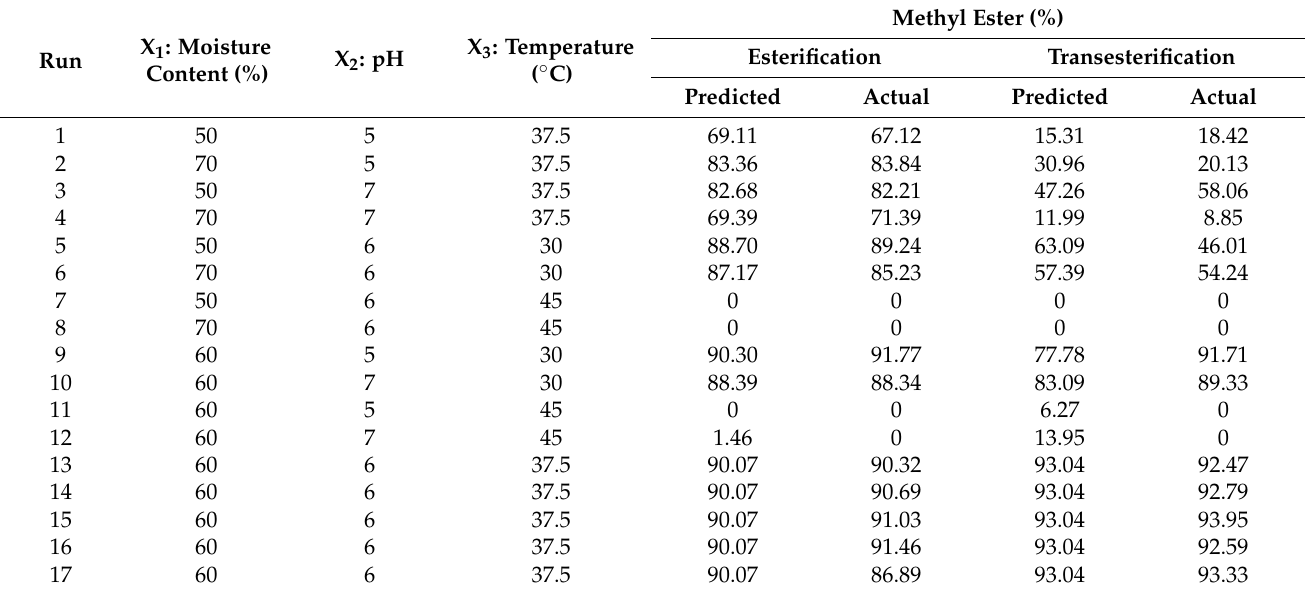
Table 1. Box-Benhken design matrix of response surface methodology with experimental and predicted values of fatty acid methyl esters synthesis by transesterification and esterification